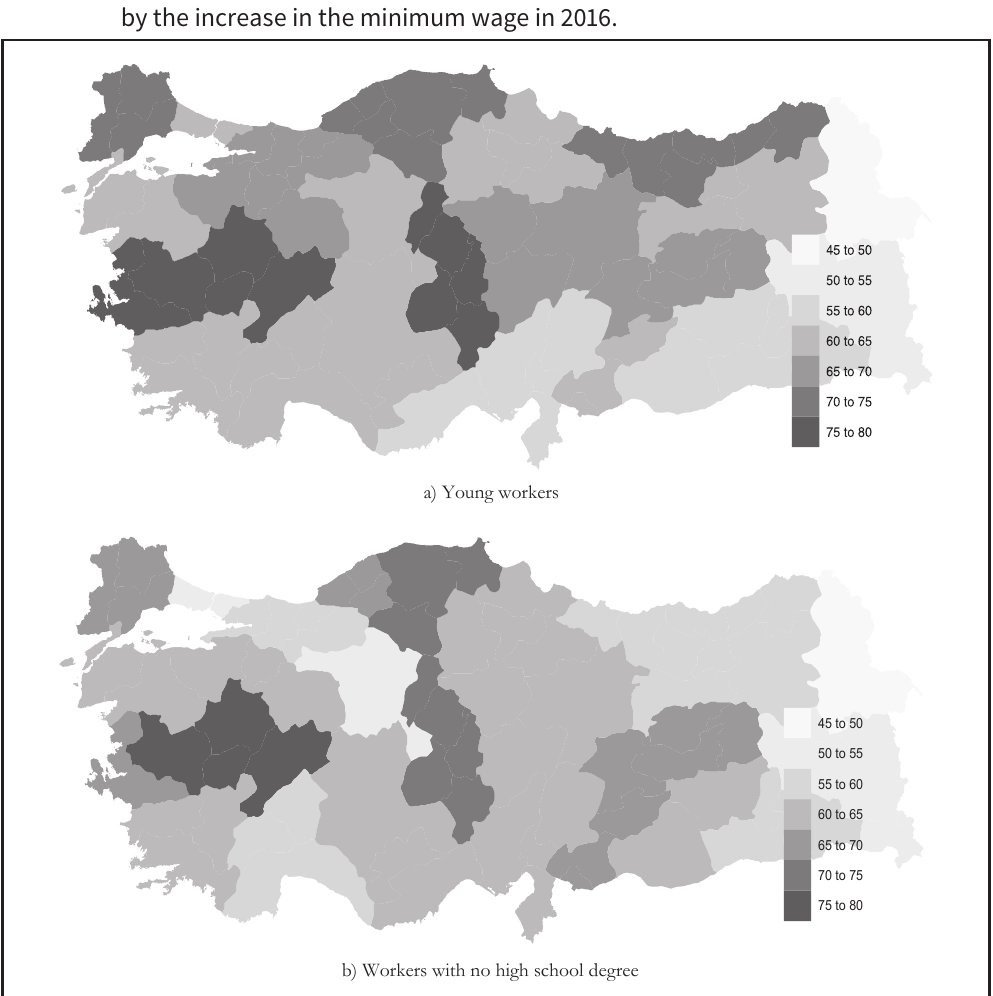
Figure 6 Fraction of young or less than high school educated workers potentially affected by the increase in the minimum wage in